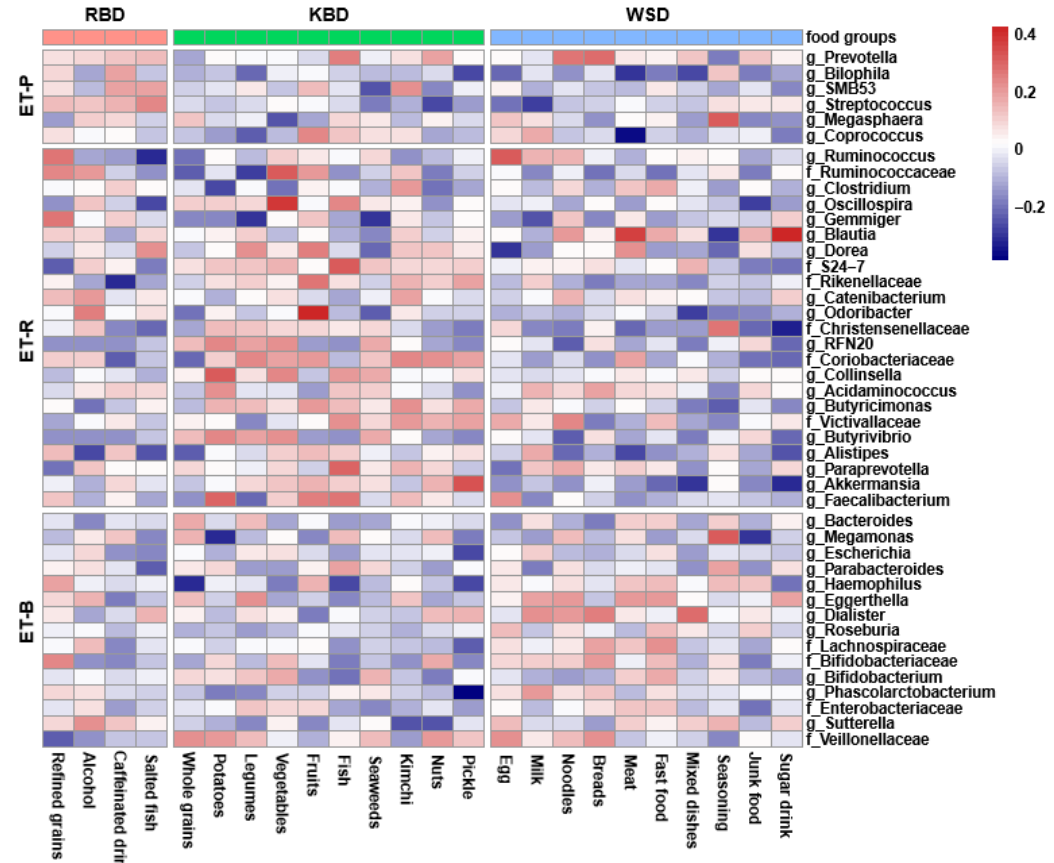
Figure 5. Heatmaps of partial Spearman correlations between intakes of food groups in each dietary pattern and relative abundance of gut microbiota at the genus level. Food groups were gathered into each dietary pattern, and fecal bacteria were arranged into one enterotype when the bacteria contents were higher than the other enterotypes, and they were classified into ET-P, Prevotellaceae ; ET-R, Ruminococcaceae ; ET-B, Bacteroidaceae .